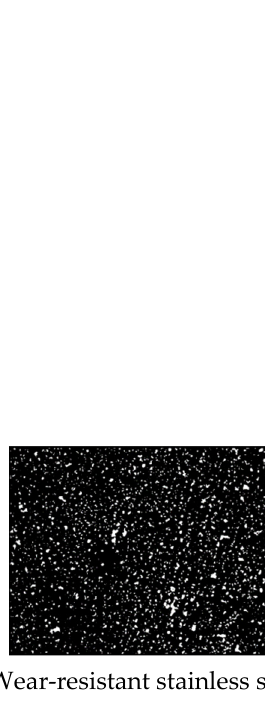
Figure 5. Image of dispersion of NR/BR composites after friction with different metals. Table 6. Dispersion value of NR/BR composites after friction with different